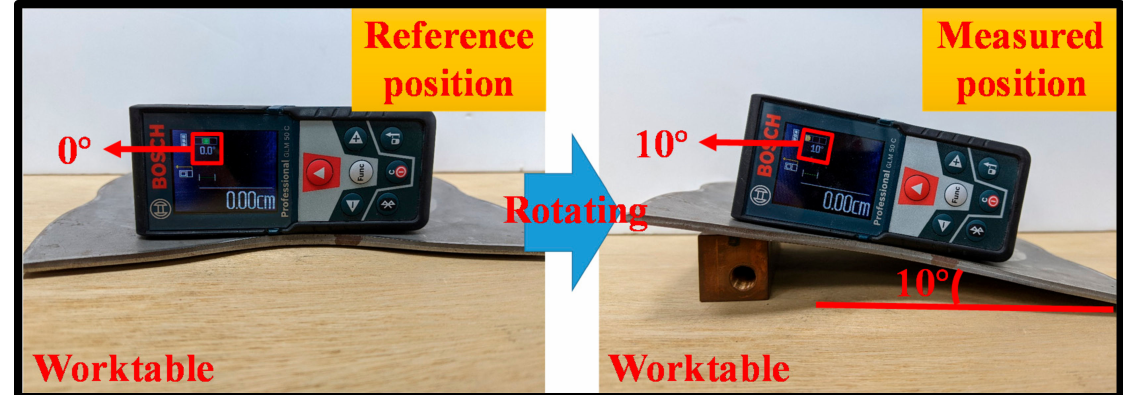
Figure 9. Setup of standard rotation angles for different estimation poses of the dynamic workpiece using the professional laser rangefinder of BOSCH.